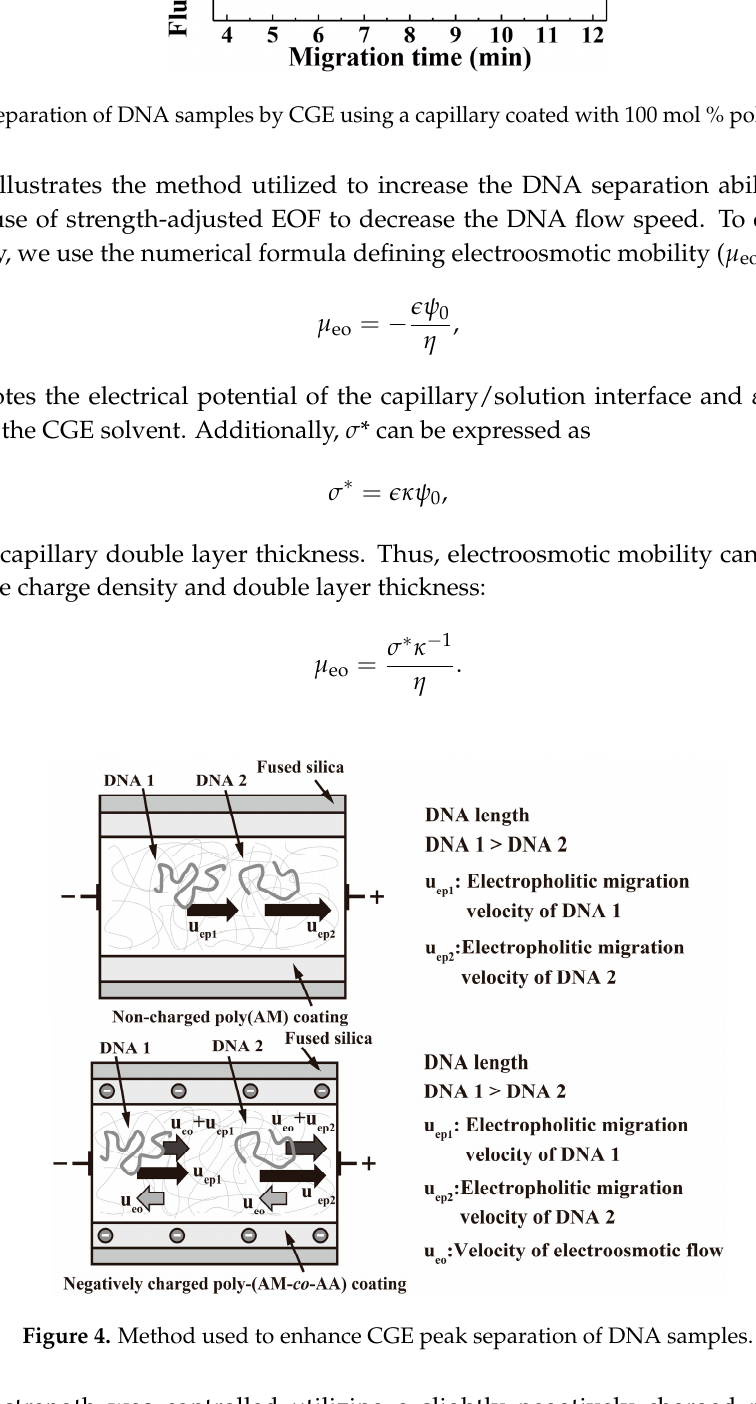
Figure 3. Separation of DNA samples by CGE using a capillary coated with 100 mol % polyacrylamide.